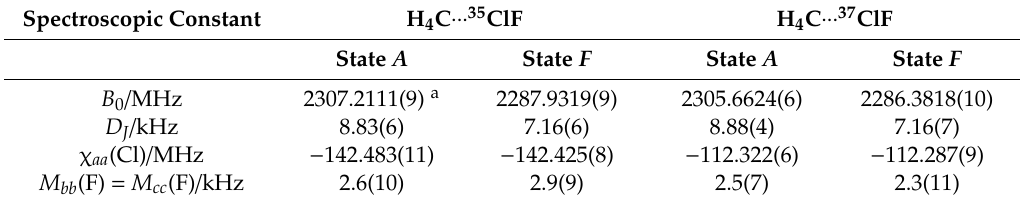
Table 1. Determined spectroscopic constants of H 4 C ··· 35 ClF and H 4 C ··· 37 ClF. Spectroscopic